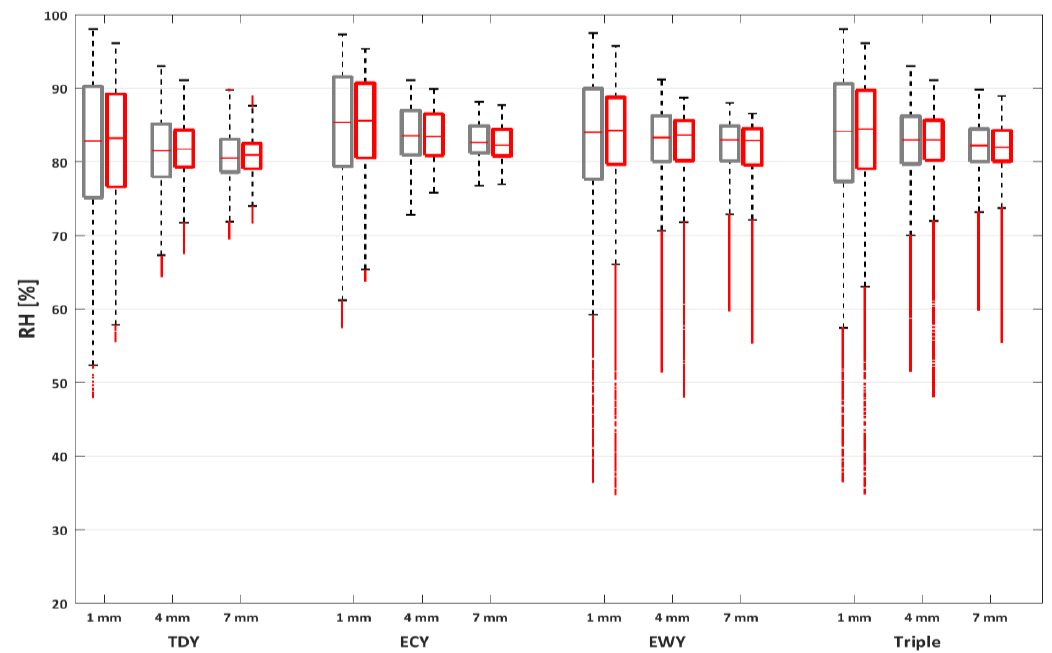
Figure 5. RH distribution in wood at different depths, using WUFI ® Pro (red boxes) and the Simplified model (grey boxes). Results are for the typical heavy building subjected to three weather data sets; typical downscaled year (TDY), extreme cold year (ECY) and extreme warm year (EWY). Triple set represents distribution of all the three data sets together.